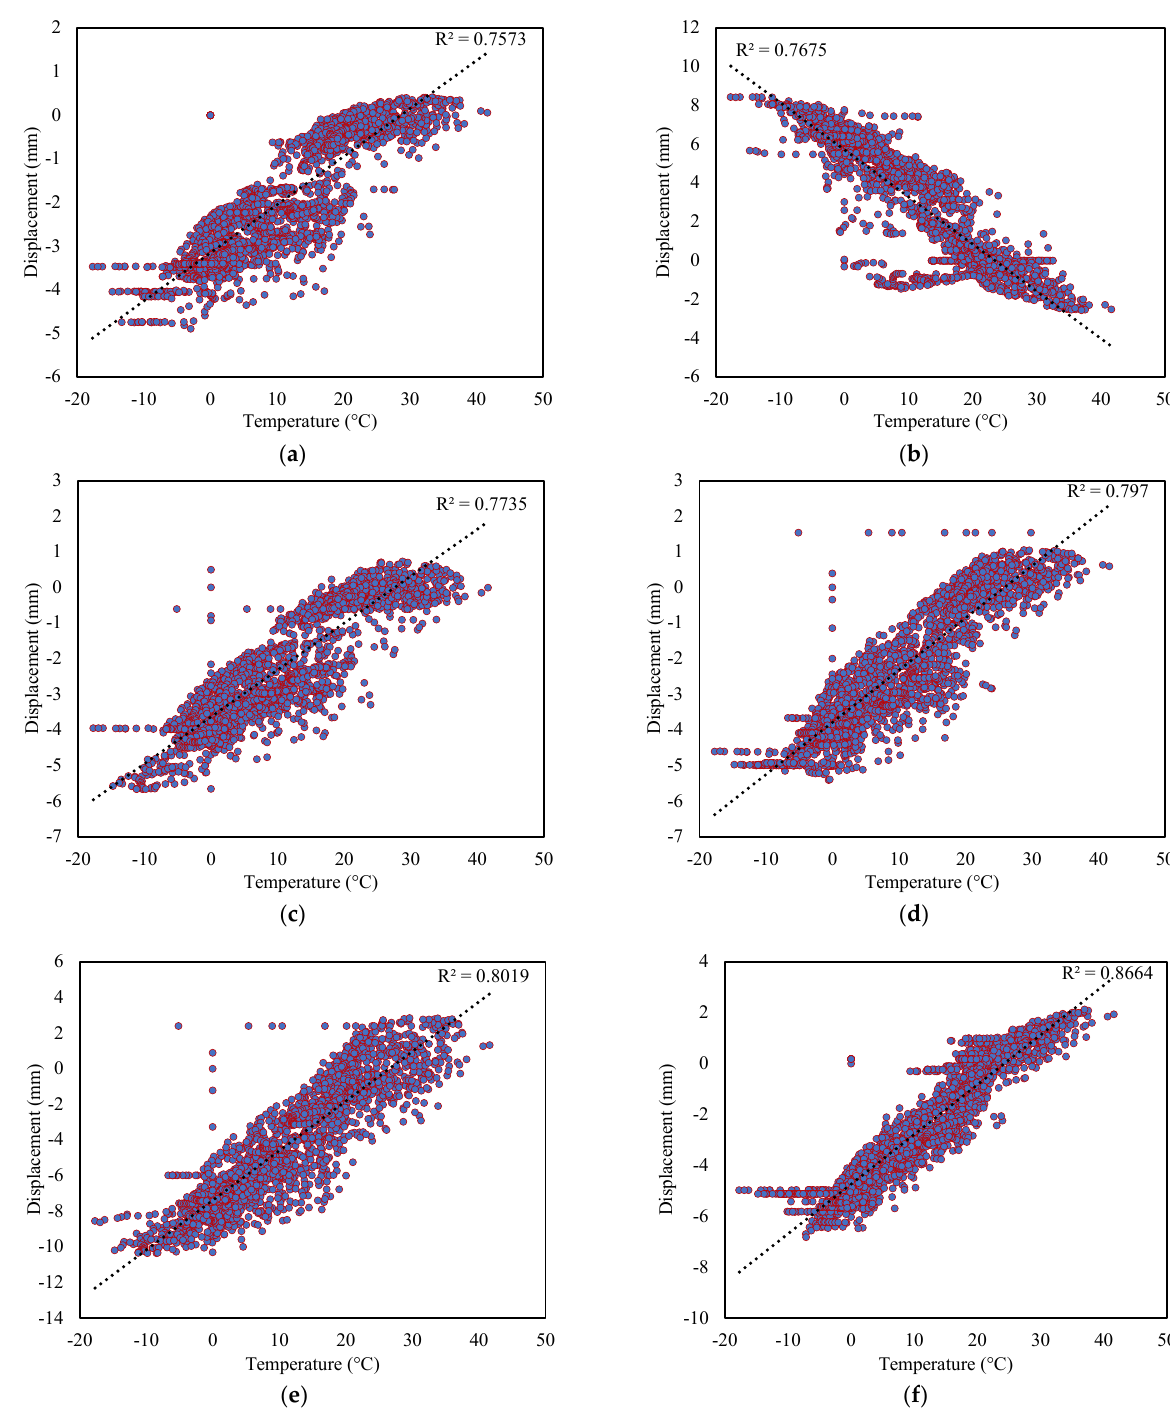
Figure 12. Measured temperatures and displacements ( a ) LVDT #1, ( b ) LVDT #2, ( c ) LVDT #3, ( d ) LVDT #4, ( e ) LVDT #5, and ( f ) LVDT #6.